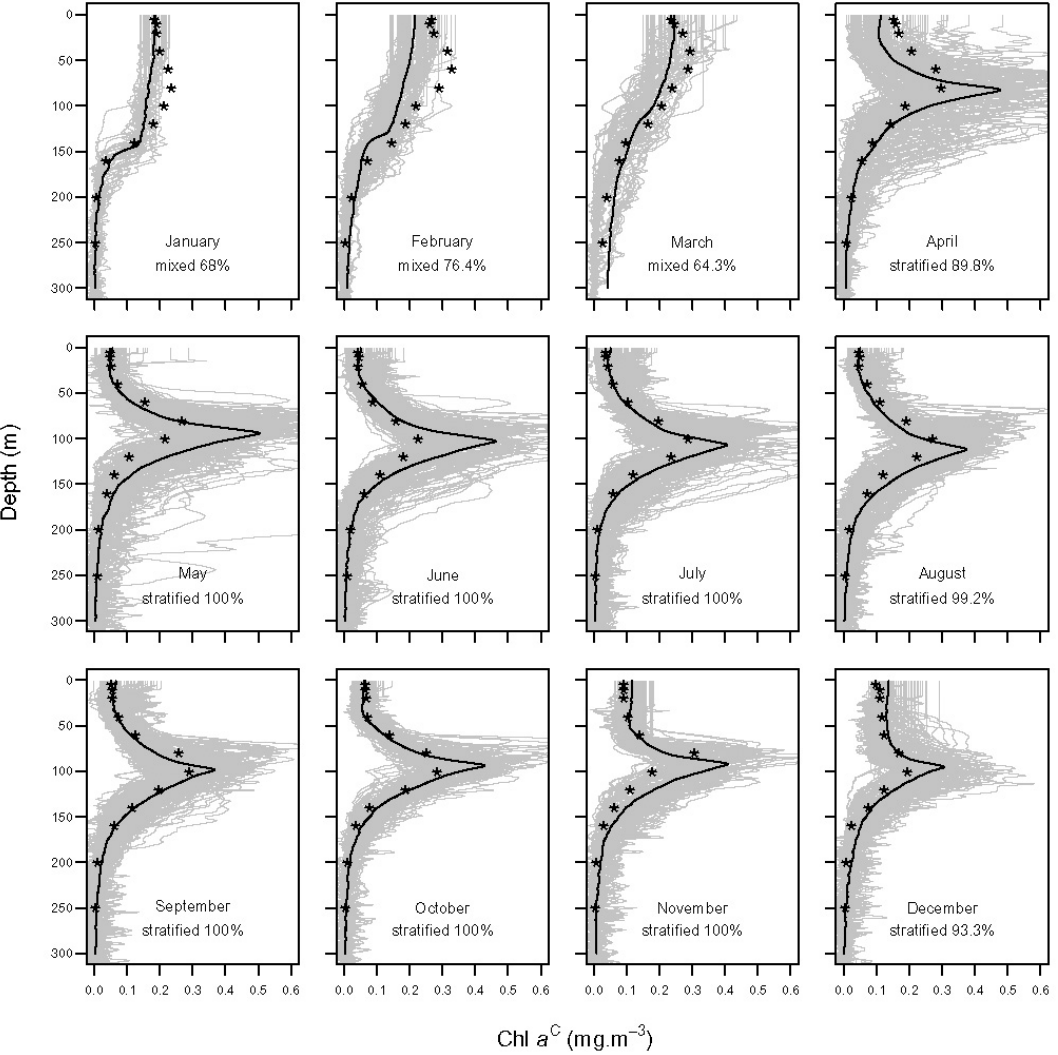
Fig. 6. Comparison of the BATS monthly fluorescence-based Chl a C climatology (black solid lines) to the HPLC-based climatology (black stars; see text and Appendix A for details about computation methods). For the fluorescence-based climatology, the retained shape (i.e. “stratified” or “mixed”) is indicated with its percentage of occurrence, and grey lines display all the “satellite-corrected” profiles representing the dominant